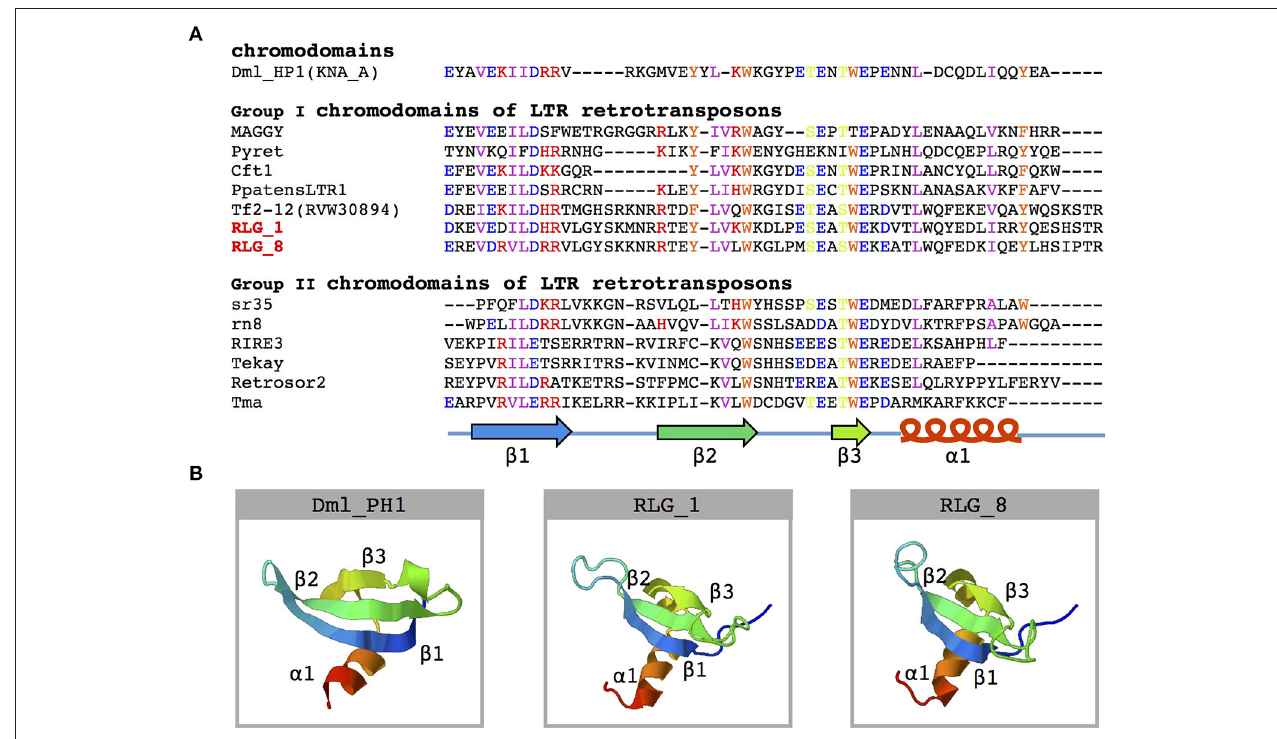
FIGURE 3 | Amino acid sequence alignment and structure prediction of the chromodomain. (A) Multiple alignments of amino acid sequences of known chromodomains and chromo-like motifs from the RLG_1 and RLG_8 families. A schematic representation of β -strands (arrows) and α -helix (cylinder) is on the bottom. The GenBank accession numbers for the sequences used are: DmHP1(KNA_A)-M57574 from Drosophila melanogaster ; MAGGY-L35053 and Pyret-AB062507 from Magnaporthe grisea ; Cft1-AF051915 from Cladosporium fulvum ; PpatensLTR1-XM_001752430 from Physcomitrella patens ; Tf2-12-RVW30894 from Vitis vinifera ; sr35-AC068924, rn8-AK068625 and RIRE3-AC119148 from Oryza sativa ; Tekay-AF050455 from Zea mays ; RetroSor2-AF061282 from Sorghum bicolor ; Tma-AF147263 from Arabidopsis thaliana . (B) Predicted three-dimensional structure of chromodomains from the DmHP1 protein (M57574) and the RLG_1 and RLG_8